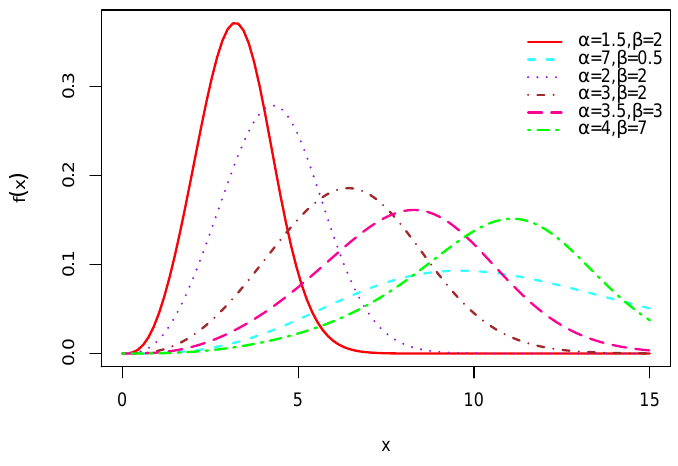
Figure 1. Curves of the pdf of the Marshall–Olkin length-biased Maxwell (MOLBM) distribution for different values of the